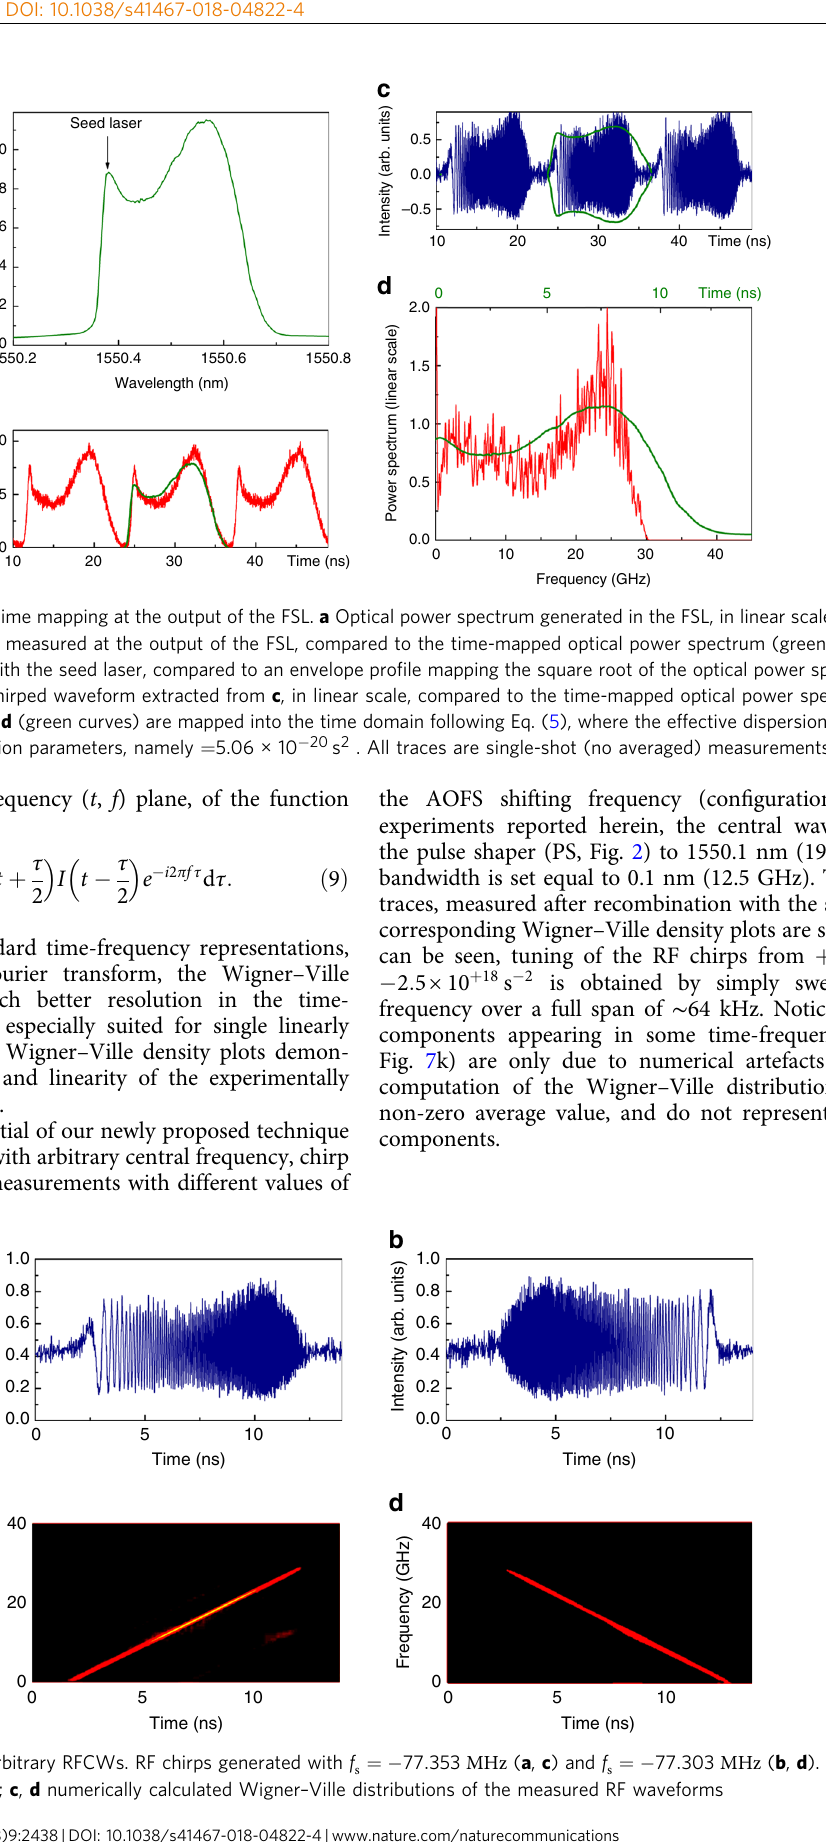
Fig. 6 Examples of broadband arbitrary RFCWs. RF chirps generated with f recorded by the fast photodiode; c , d numerically calculated Wigner – Ville distributions of the measured RF waveforms